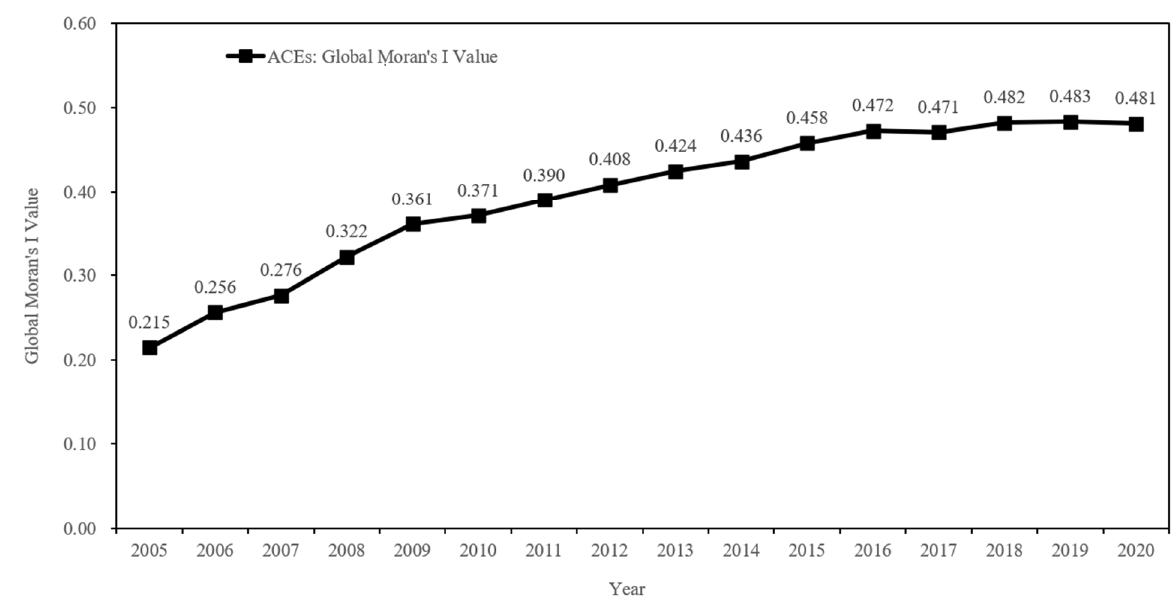
Figure 6. Trend of Moran’s I index values for ACEs in Jiangsu Province from 2005 to 2020.